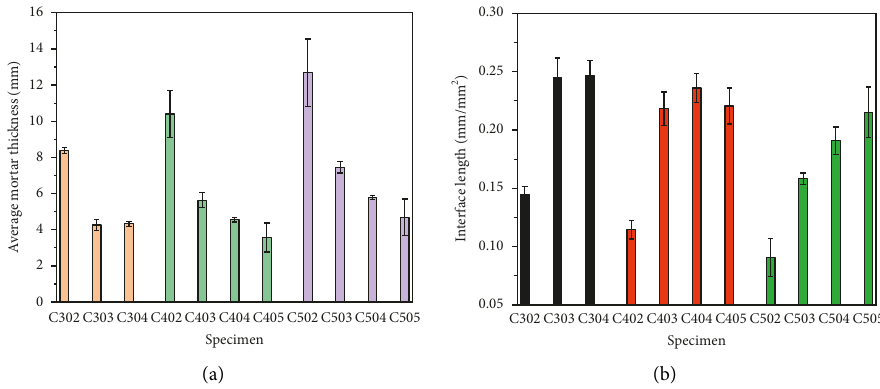
Figure 13: Schematic diagram of the interactions among aggregate, mortar, and pores.